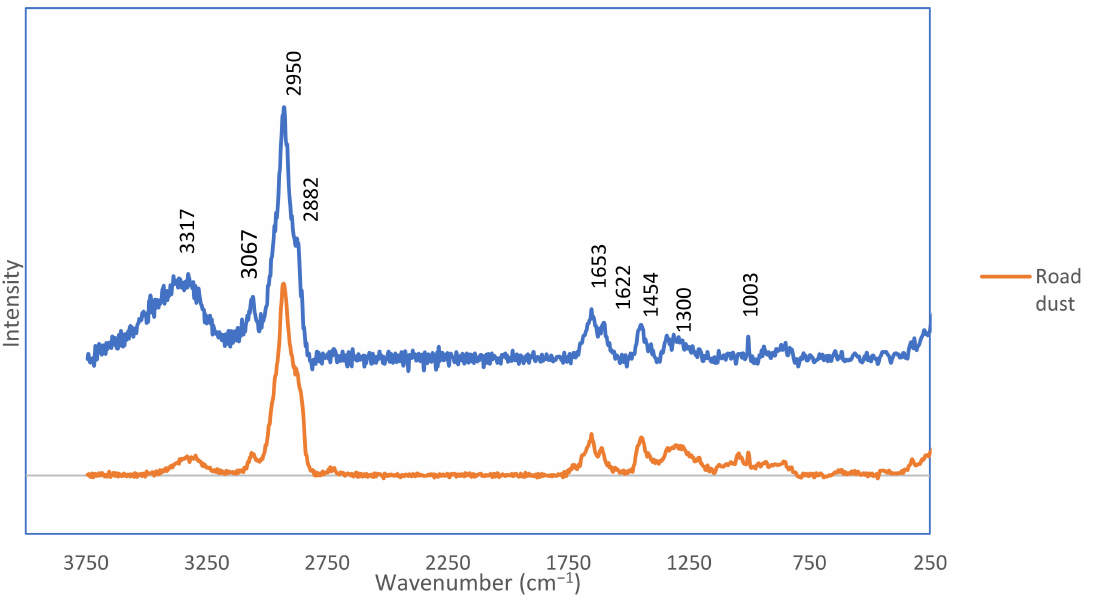
Figure 7. The typical Raman spectra of black fragments from the soil and road dust